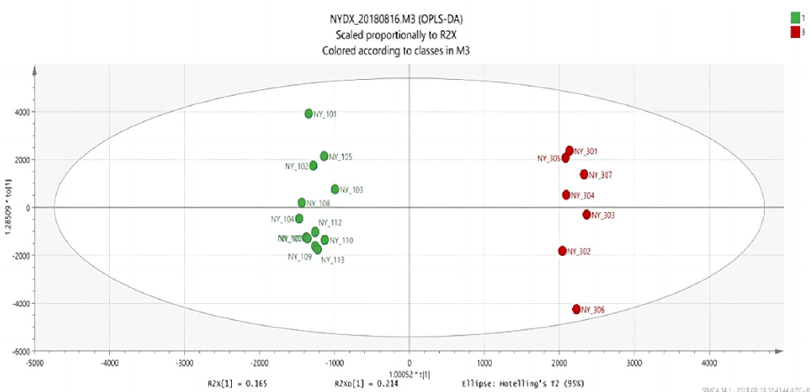
Figure 8. OPLS-DA score plots between group 1 and group 3.